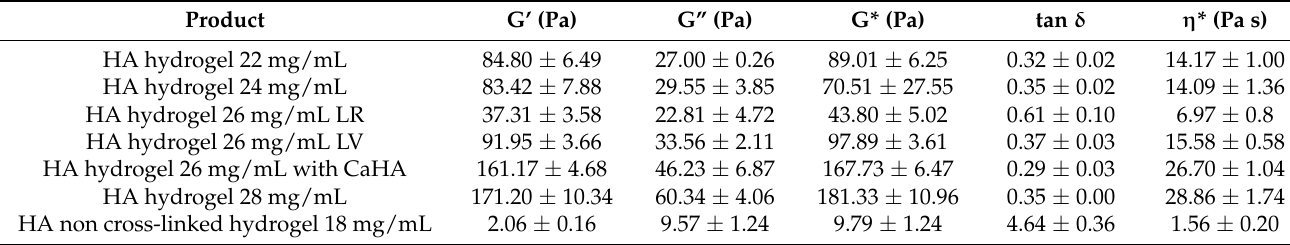
Table 3. Rheological characterization of seven HA hydrogel dermal fillers provided by Matex Lab S.p.A. obtained at a fixed shear strain (1%) and temperature (37 ◦ C) in their linear viscoelastic region (LVER). Data are represented as averages and SDs.